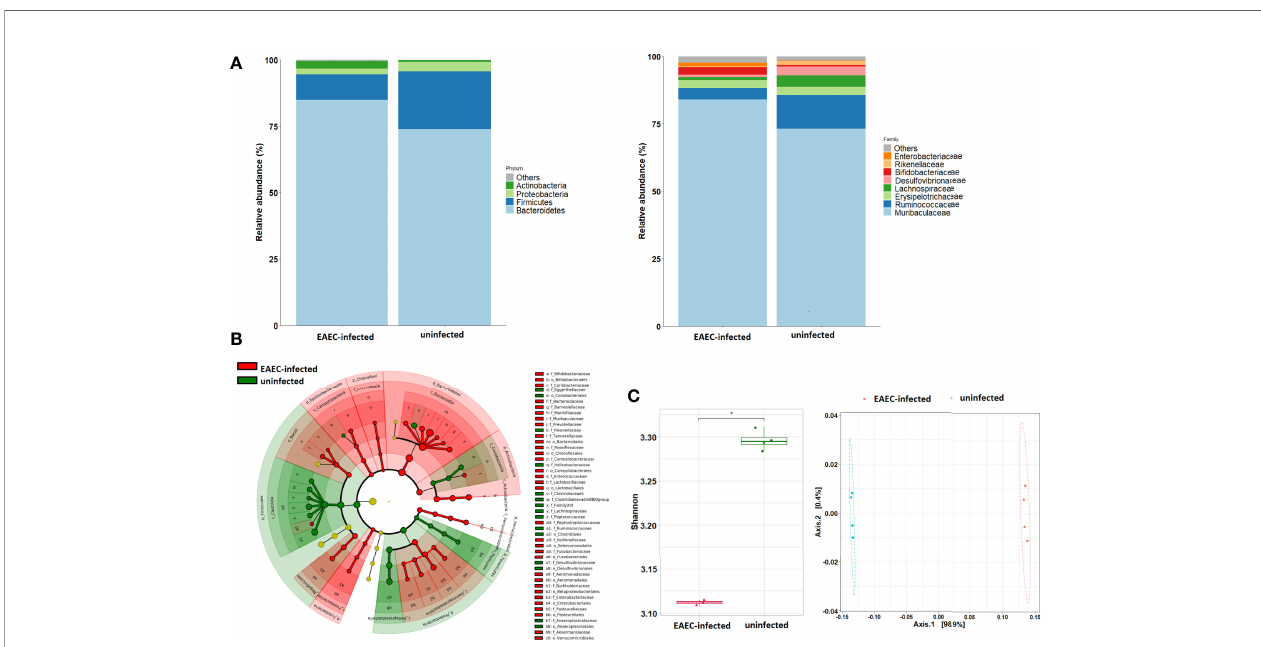
FIGURE 4 | Impact of EAEC 042 infection on the gut microbial community at 21 days post-challenge. (A) Community pro fi le at phylum and family taxonomic levels. Taxa units were organized based on the most abundant taxa; fewer representative taxa were grouped as others. (B) Classi fi cation tree of mice EAEC 042-infected (red color) and uninfected (green color) bacterial communities based on LEfSe analysis, with sizes of nodes re fl ecting relative abundances. (C) Alpha diversity metrics were compared between EAEC 042-infected and uninfected mice using Shannon indices, and beta diversity analysis was performed using NMDS. Each group (N = 4), * p < 0.01, versus uninfected mice. EAEC, enteroaggregative Escherichia coli ; LEfSe, linear discriminant analysis effect size; NMDS, non-metric multidimensional scaling